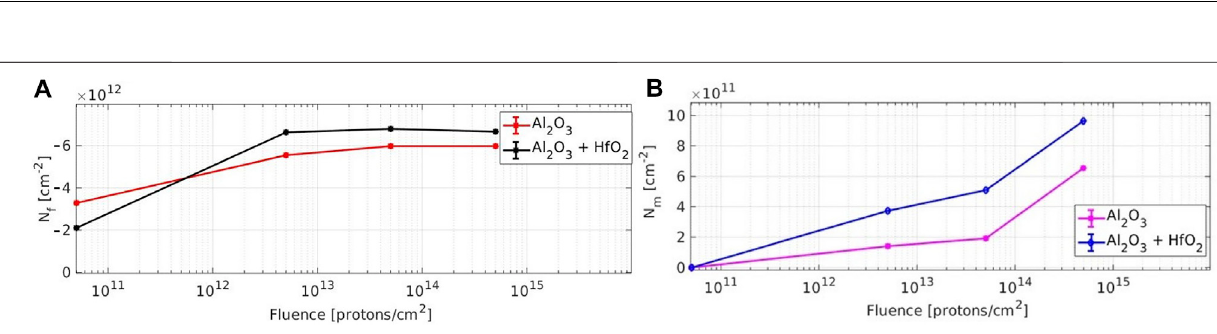
TABLE 1 | Details of the surface damage